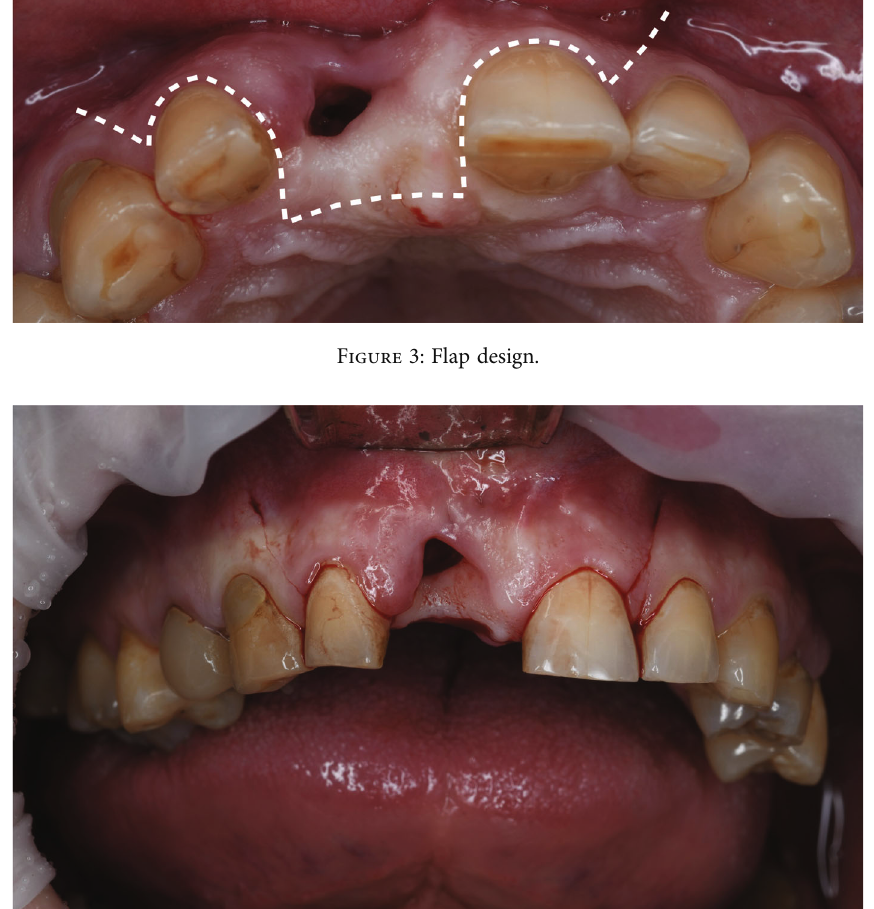
Figure 4: Vertical hockey-stick-shaped releasing